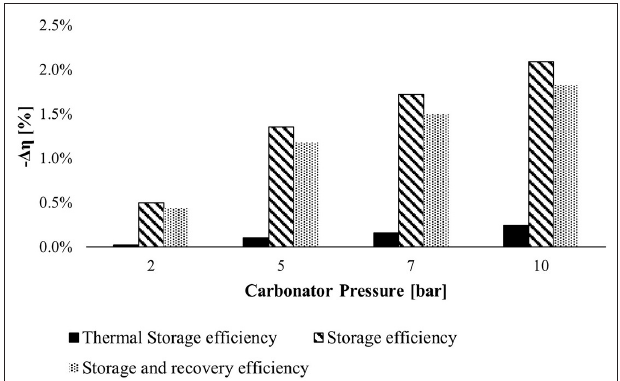
FIGURE 8 | The negative efficiency variation at various carbonator pressures with respect to efficiency computed at 1.2 bar. The efficiencies decrease, increasing the carbonator pressure.